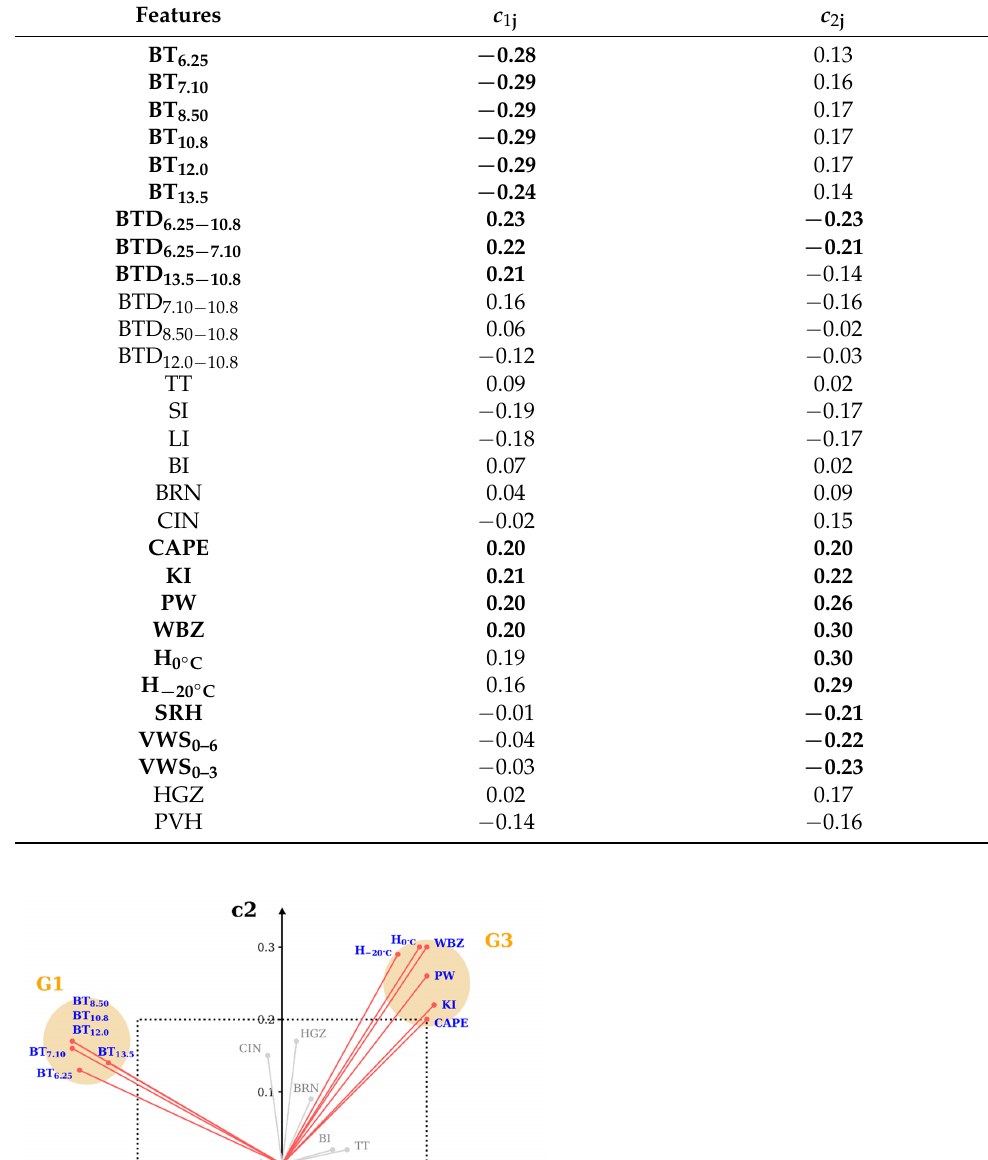
Table 4. Feature coefficients for the first ( c 1 j ) and second ( c 2 j ) principal components (PCs). The bold fonts mark out the features and coefficients whose magnitudes are greater than 0.2.